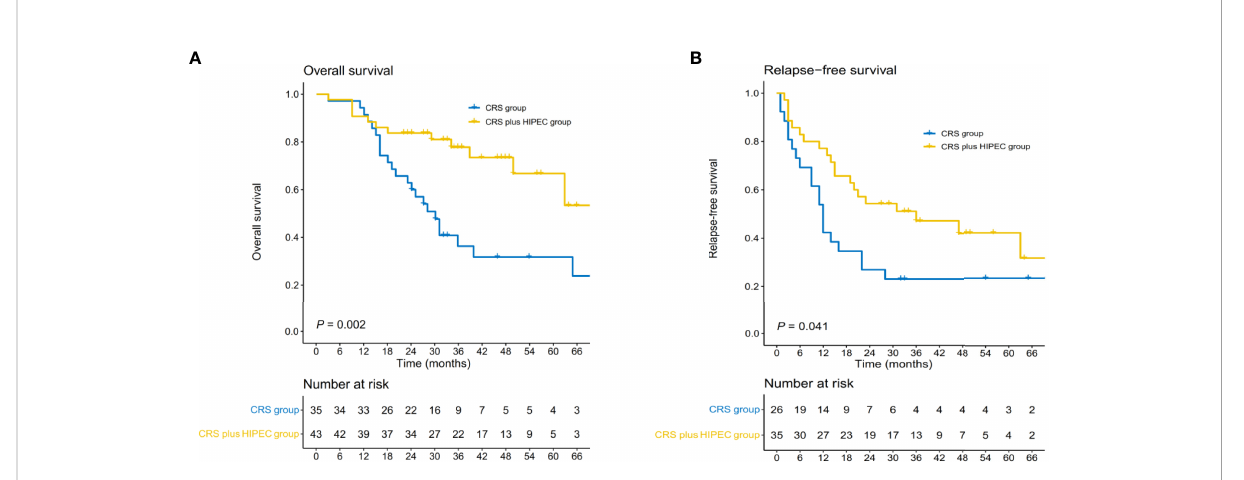
FIGURE 2 Kaplan-Meier estimates of overall survival (A) and relapse-free survival (B) .